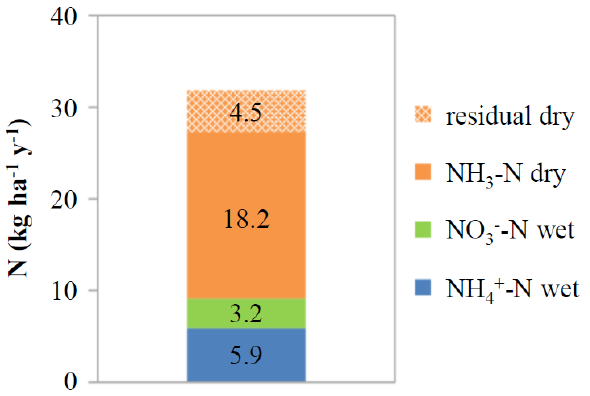
Figure 3. Total annual N deposition calculated as averages of monthly measurements